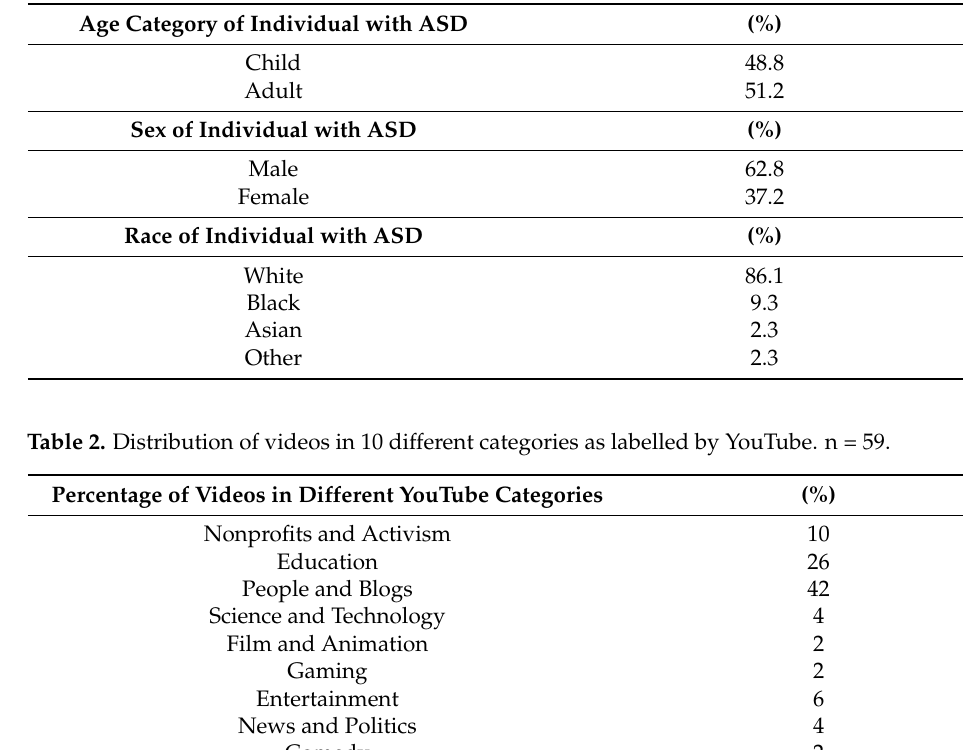
Table 1. Percentage of individuals with ASD, with respect to age, sex, and race. n = 31.